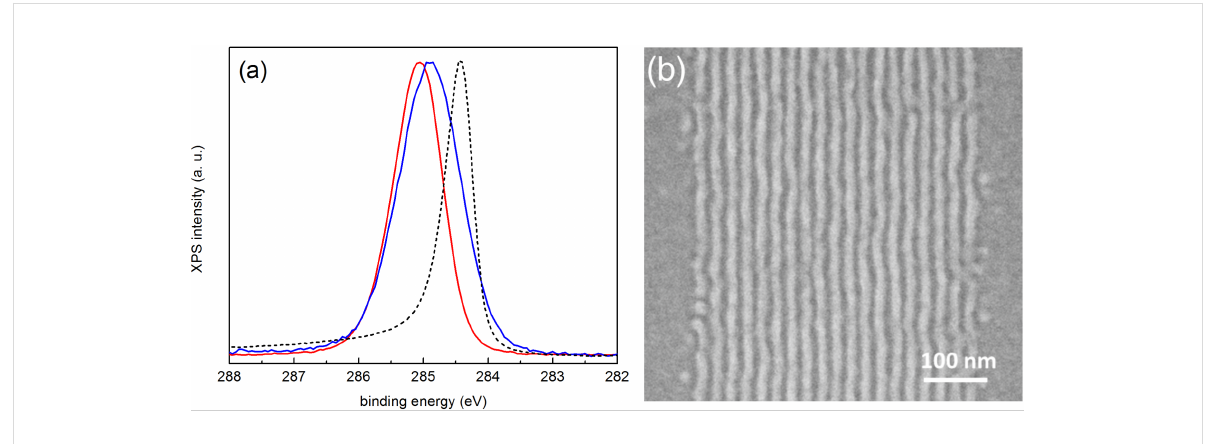
Figure 6: (a) C 1s XPS spectra of a grafted brush PS–OH layer after annealing at 230 °C and cooling in nitrogen (continuous red line), a sample modified by EBL (continuous blue line), and HOPG (discontinuous black line) using a PHOIBOS150 analyzer and monochromatic 1486.6 eV excita- tion. (b) SEM image of a 22 nm pitch PS- b -PMMA aligned in a pattern created by direct electron beam